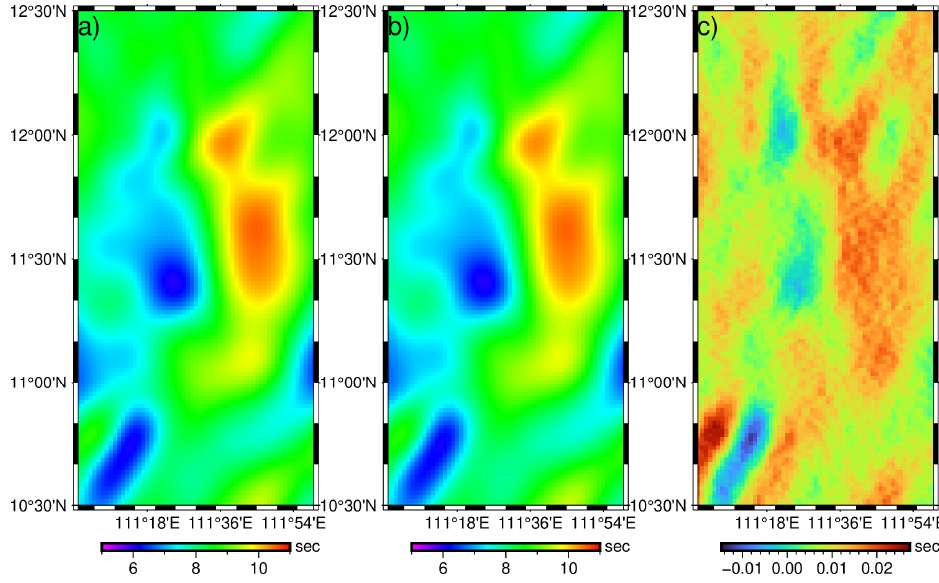
Figure 6. East-west component of DV: ( a ) true value; ( b ) recovered value; ( c ) error.